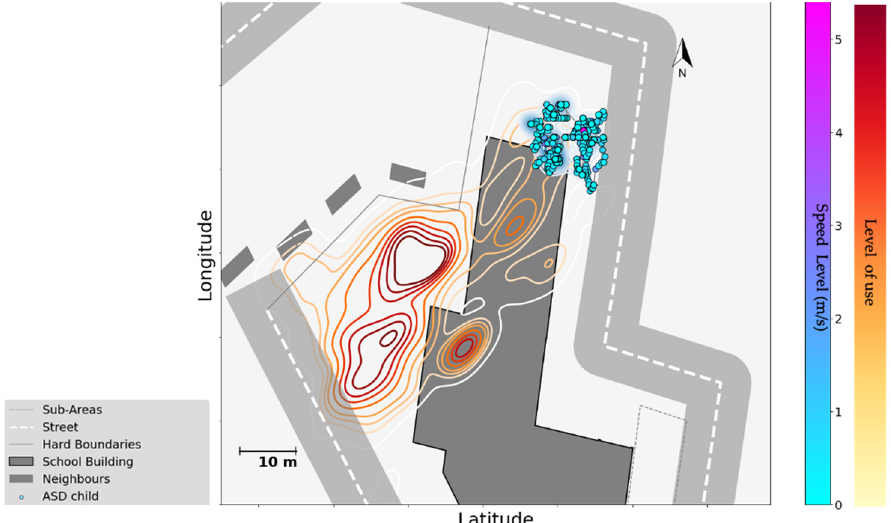
Figure 9. The use of space by an autistic child in comparison with its playgroup in school A. The level of use is analysed via GPS data, and obtained contours are colour coded from the lowest level of use to the highest following the colour bar (from yellow to red). The GPS location of the autistic child is plotted on the floor plan, colour coded by the speed level from the lowest speed to the highest, following the colour bar (from blue to pink).